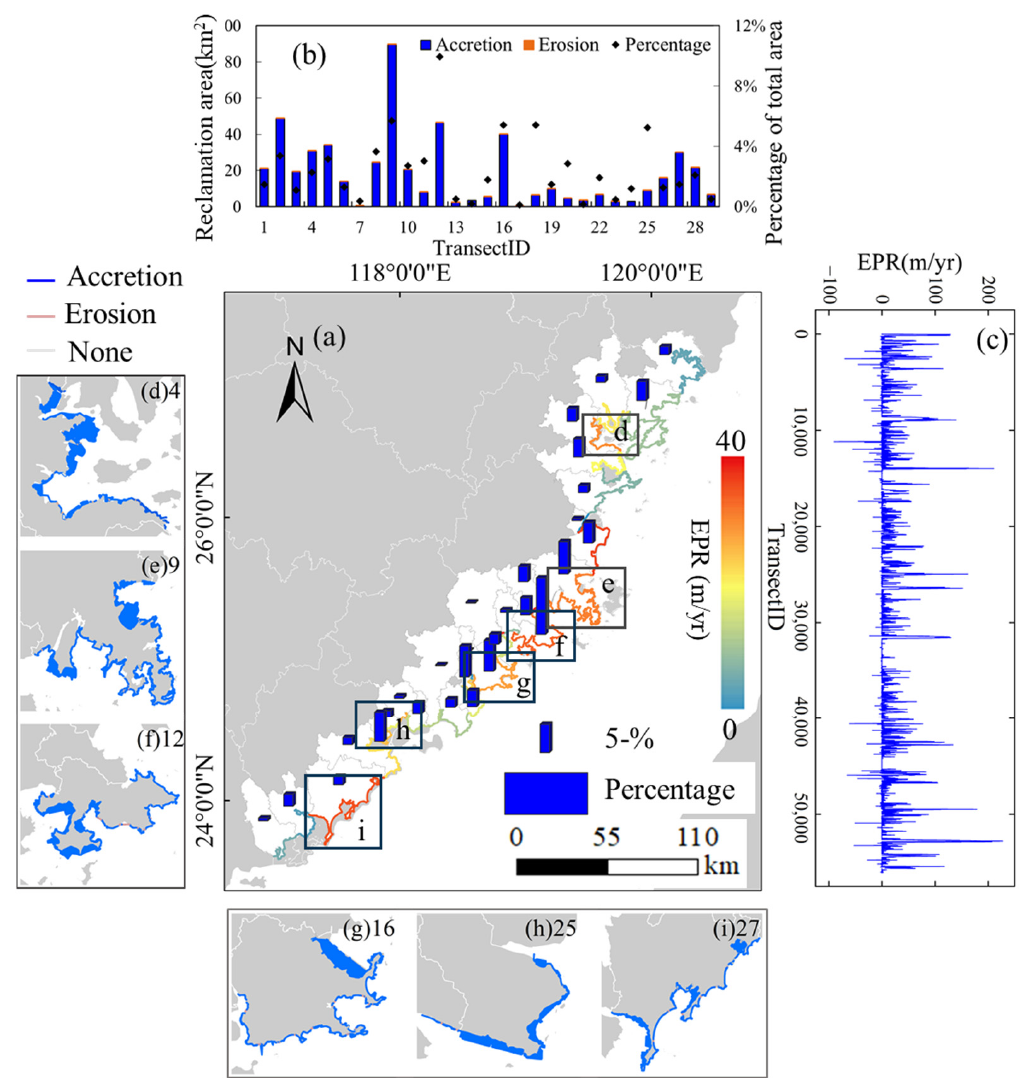
Figure 5. ( a ) EPR and the proportion of reclamation area in different districts; ( b ) reclamation area including accretion and erosion of each district; ( c ) EPR of the continental coastline of every transect; ( d – i ) Jiaocheng, Fuqing, Xiuyu, Hui’an, Haicang, Zhangpu Districts with huge dynamic change of EPR and reclamation area in different cities.